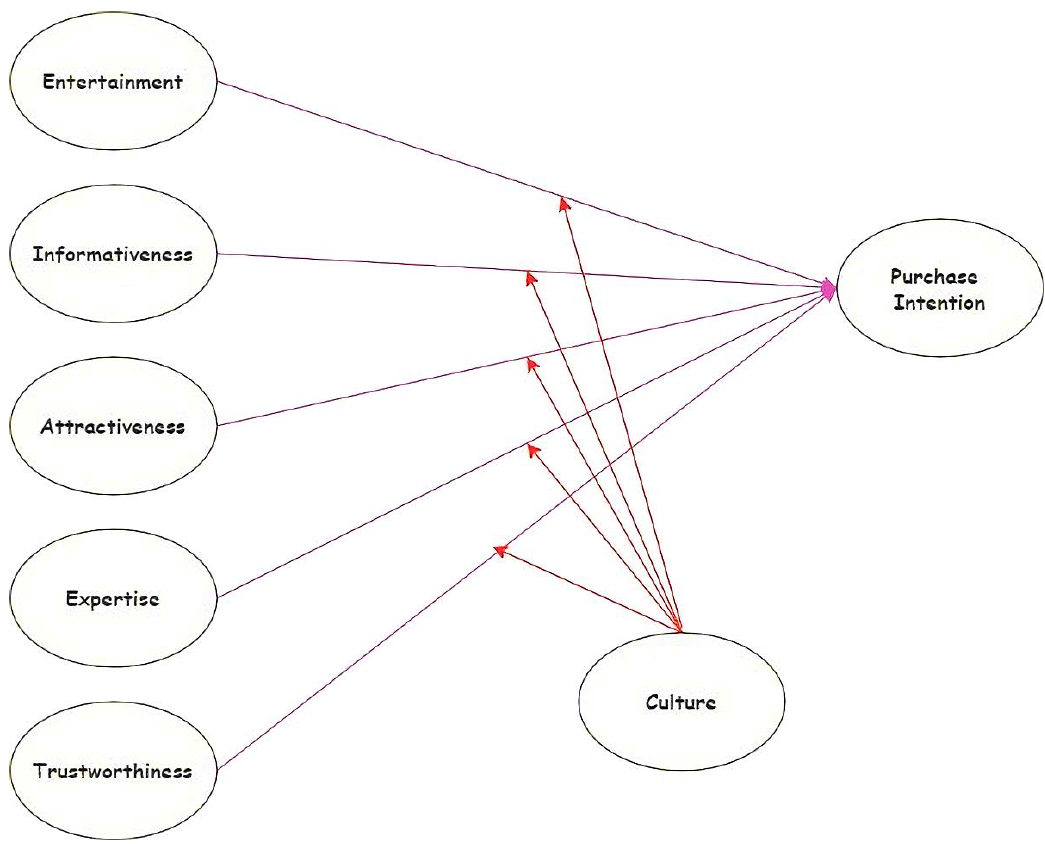
Figure 1. Conceptual Framework of the Study